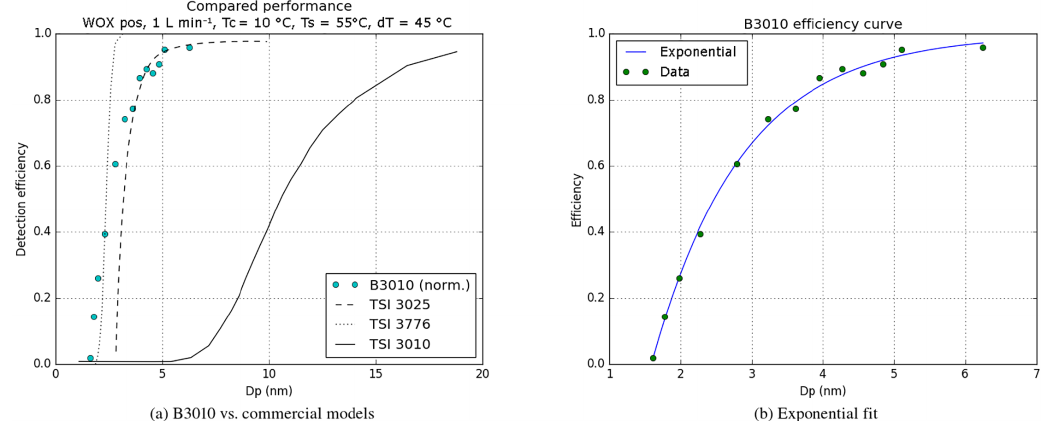
Figure 9. Gain in performance. Tungsten oxide particles. The data from TSI CPCs are taken from product brochures (a) . The B3010 efficiency is fit with an exponential curve (b) to retrieve the cutoff diameter. The data from the B3010 are normalized.